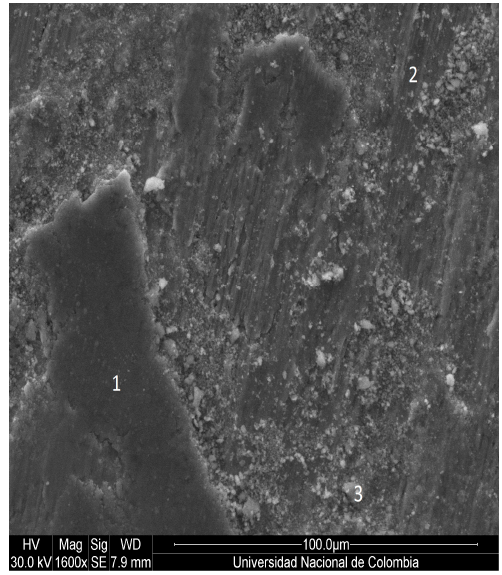
Figure 8. Chemical analysis of pin on disk wear tracks of NiTec coatings deposited at 11.04 SCFH. Table 4. Chemical composition of the wear tracks of NiTec in zones 1, 2, and 3 of the Figure 8. Unn. C. Norm. C. Atom. C. (1. Sigma) Zone Element (wt.%) (wt.% ) (at.% ) (wt.% )